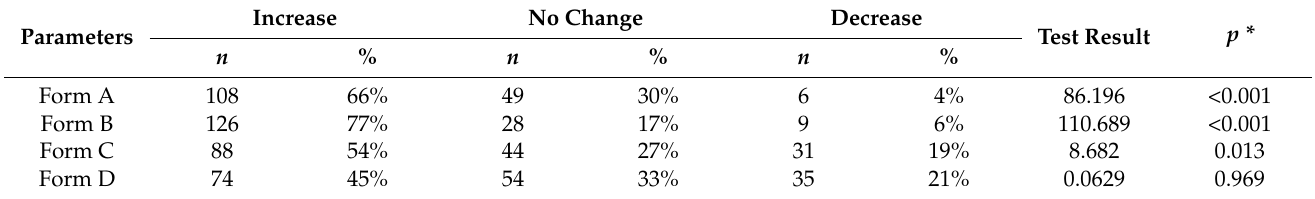
Table 3. Effects of treatment on concentration of sperm motility forms in the ejaculate.